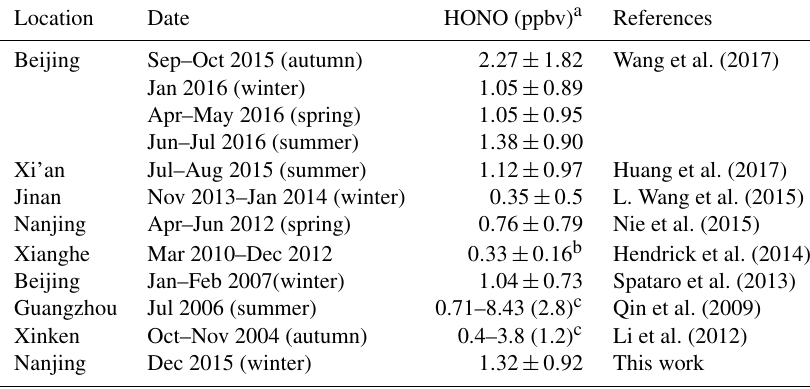
Table 1. Overview of HONO measurements performed in Nanjing and other cities in China.